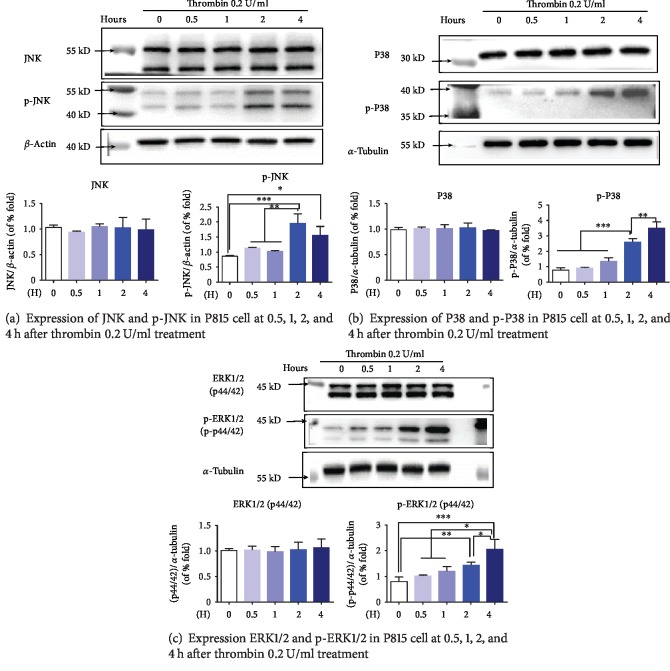
Expression of MERKs and phospho-MAPKs (including JNK, P38, and ERK1/2) in P815 cells at 0.5, 1, 2, and 4 h after stimulation of 0.2 U/ml thrombin. The expression of p-P38, p-JNK, and p-ERK1/2 MERK in P815 cells increased obviously at 2 and 4 h after incubation with 0.2 U/ml thrombin, but not in the level of total P38, JNK, and ERK1/2. Blots are standardized to α-tubulin or β-actin expression. ANOVA was performed. Multiple comparisons were applied to compare the difference between each group. ∗ indicates that the difference between the control group and the diverse concentration of thrombin was statistically significant (∗P < 0.05; ∗∗P < 0.01; ∗∗∗P < 0.001). (a) Expression of JNK and phospho-JNK, standardized by β-actin. (b) Expression of P38 and phospho-P38, standardized by α-tubulin. (c) Expression of ERK1/2 and phospho-ERK1/2, standardized by α-tubulin.